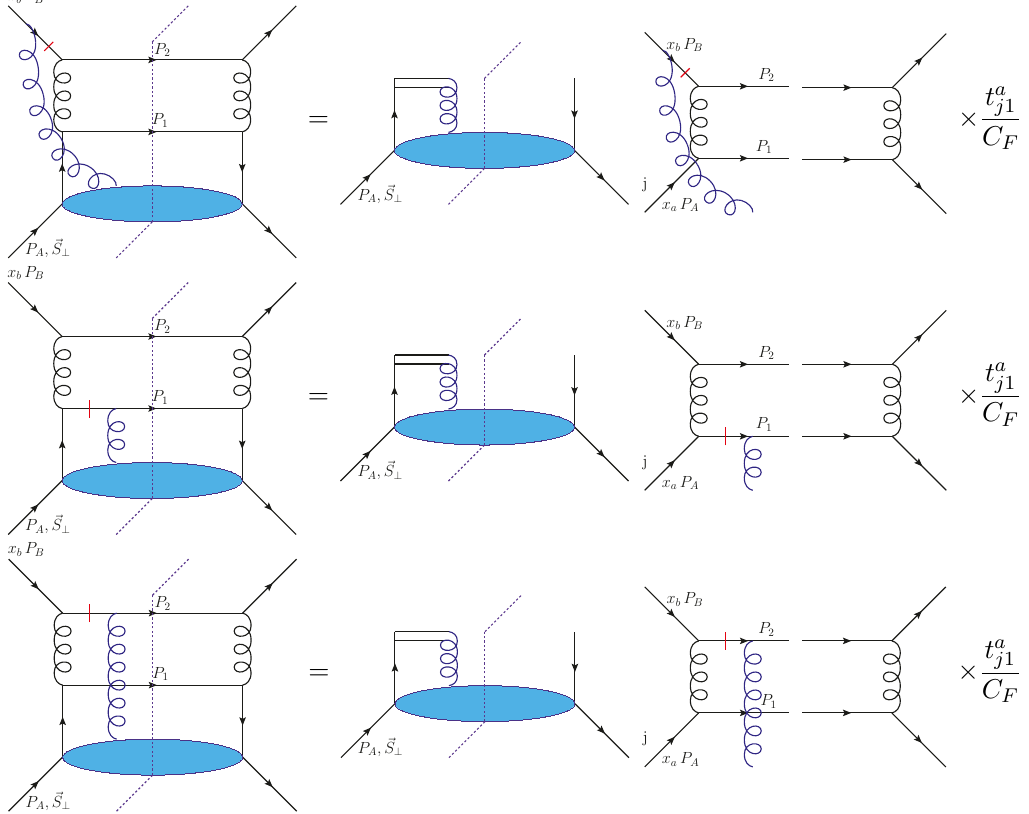
Figure 4 . A demonstration of the factorization between the Sivers function and the hard function for qq 0 → qq 0 subprocess. The red lines indicate the locations of the soft poles while the blue gluon represents the gauge link which generates the